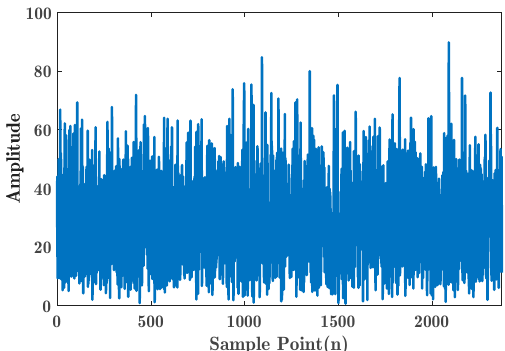
Figure 4. The hybrid signal before pulse compression.